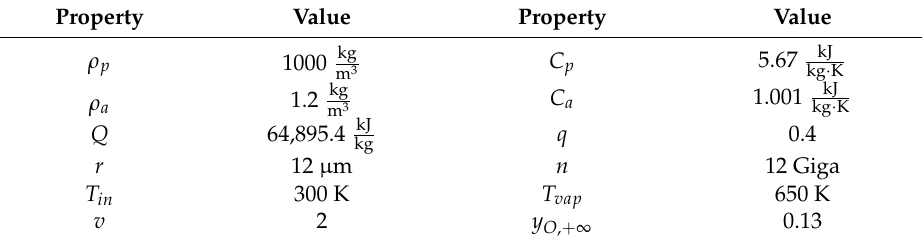
Table 2. Properties of the biofuel particles and oxidizer